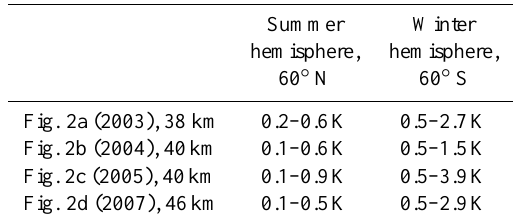
Table 1. Amplitudes of 5-day temperature perturbations at 38– 46km